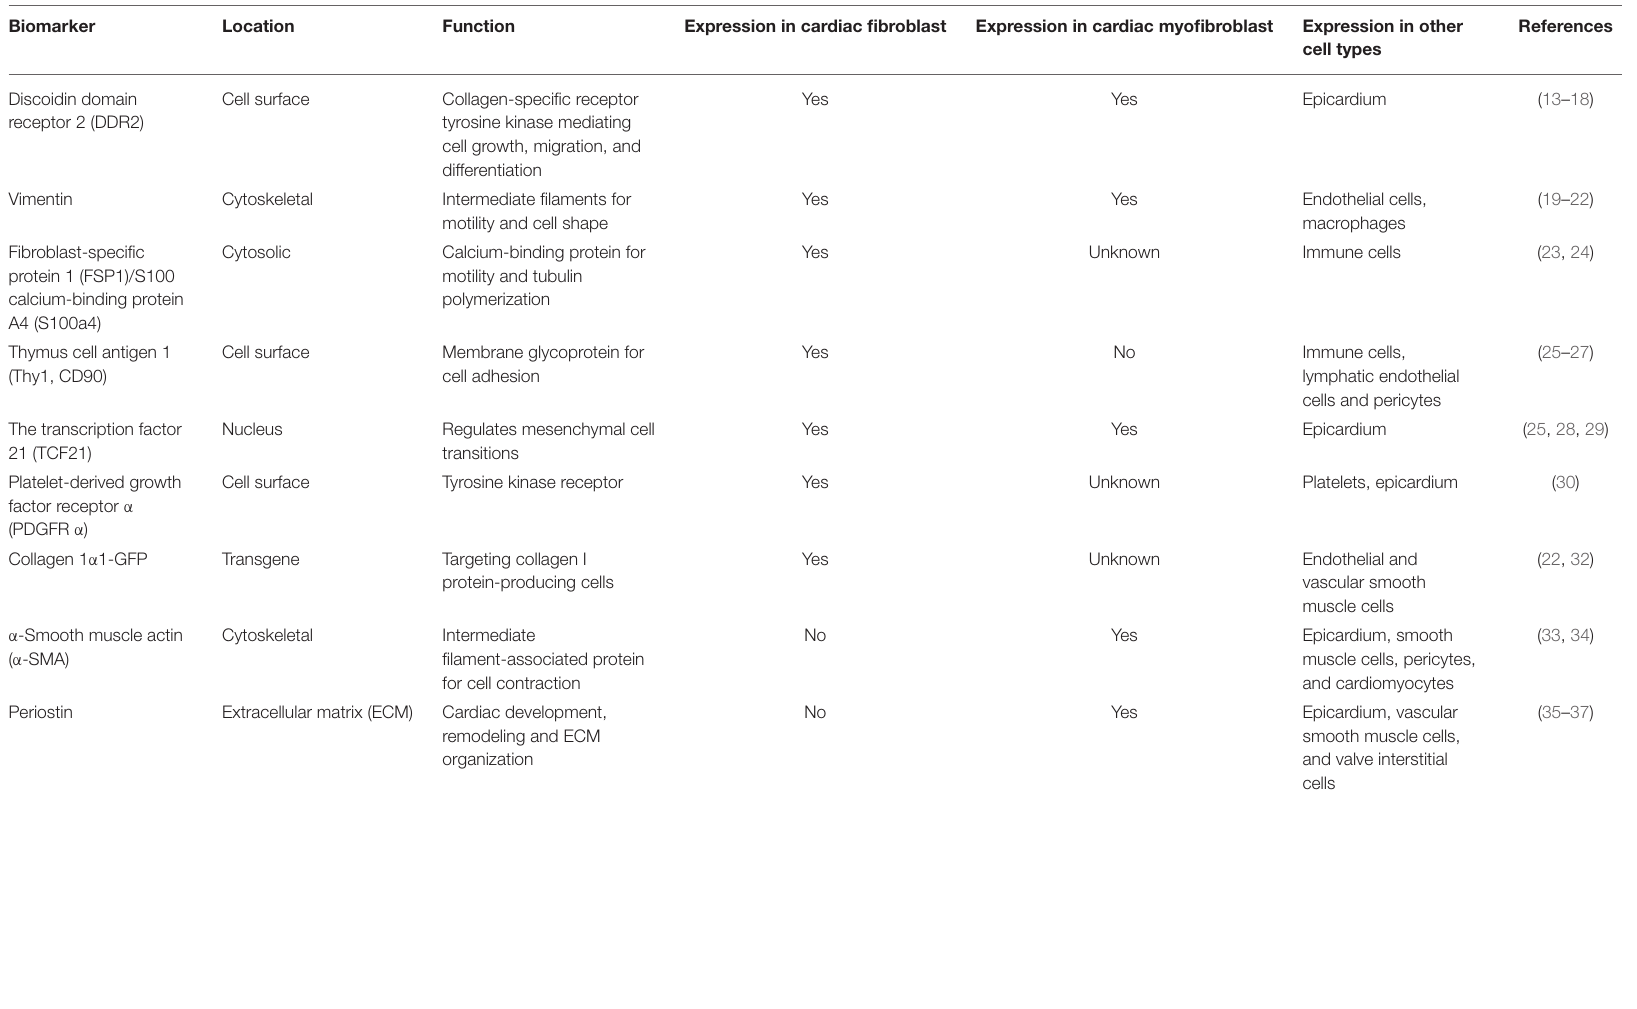
TABLE 1 | Summary of molecular markers used for the identification of cardiac fibroblasts and